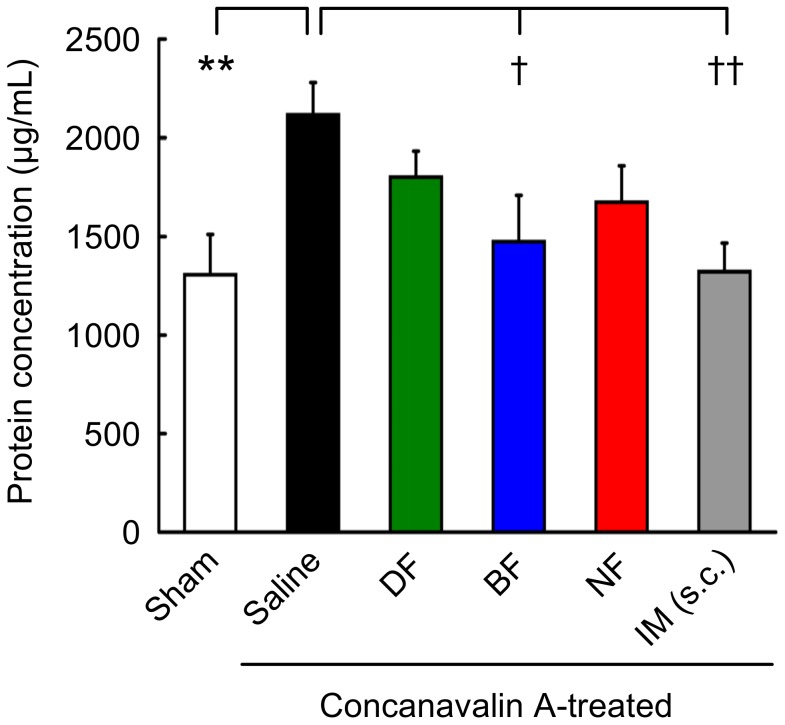
Inhibitory effect of NSAID eye drops on the concanavalin A-induced retinochoroidal inflammation in rabbits.Rabbits received 50 µL of 0.1% diclofenac ophthalmic solution (DF), 0.1% bromfenac sodium hydrate ophthalmic solution (BF), 0.1% nepafenac ophthalmic suspension (NF), physiological saline (Saline) three times a day on days -1, 0 (the day of intravitreal concanavalin A injection), 1, and 2. For positive controls, rabbits were subcutaneously injected with indomethacin (IM, 20 mg/kg) once a day during the same treatment period. Three days after the concanavalin A injection (Day 3), rabbits were euthanized and the vitreous bodies were isolated. The protein concentration in the vitreous body was measured to assess the integrity of the blood-retinal barrier. Each value represents the mean + standard error of the mean (n = 6–7). ** P <0.01 vs. Sham (Student's t test, one-side), †† P <0.01, † P <0.05 vs. Saline (Dunnett's test, one-side).